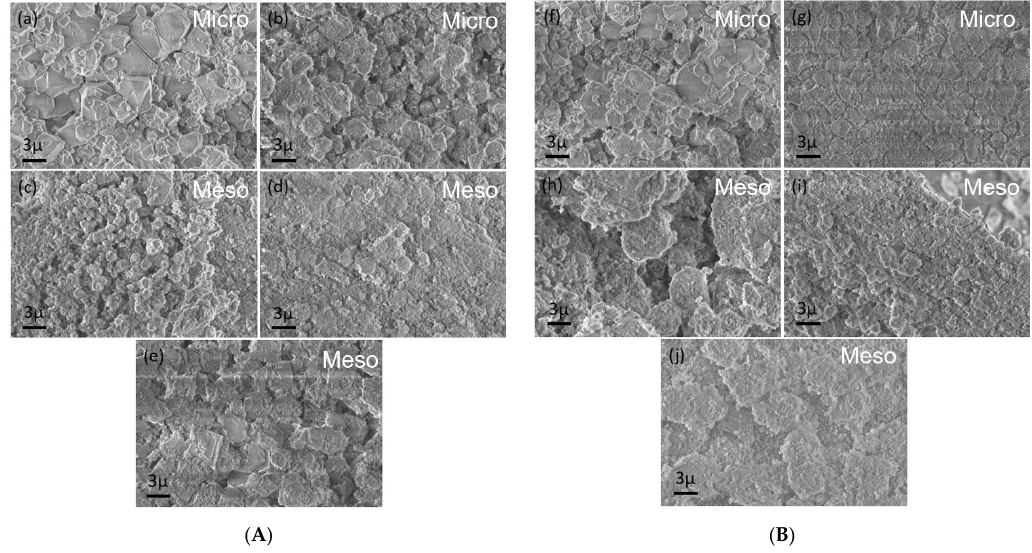
Figure 2. ( A ) SEM images of ( a ) Na ‐ SSZ ‐ 13 ‐ micro ‐ 20, ( b ) Na ‐ SSZ ‐ 13 ‐ micro ‐ 40, ( c ) Na ‐ SSZ ‐ 13 ‐ meso ‐ 0.2, ( d ) Na ‐ SSZ ‐ 13 ‐ meso ‐ 0.4, and ( e ) Na ‐ SSZ ‐ 13 ‐ meso ‐ 0.6; and ( B ) SEM images of ( f ) H ‐ SSZ ‐ 13 ‐ micro ‐ 20, ( g ) H ‐ SSZ ‐ 13 ‐ micro ‐ 40, ( h ) H ‐ SSZ ‐ 13 ‐ meso ‐ 0.2, ( i ) H ‐ SSZ ‐ 13 ‐ meso ‐ 0.4, and ( j ) H ‐ SSZ ‐ 13 ‐ meso ‐ 0.6. Catalysts 2021 , 11 , x FOR PEER REVIEW